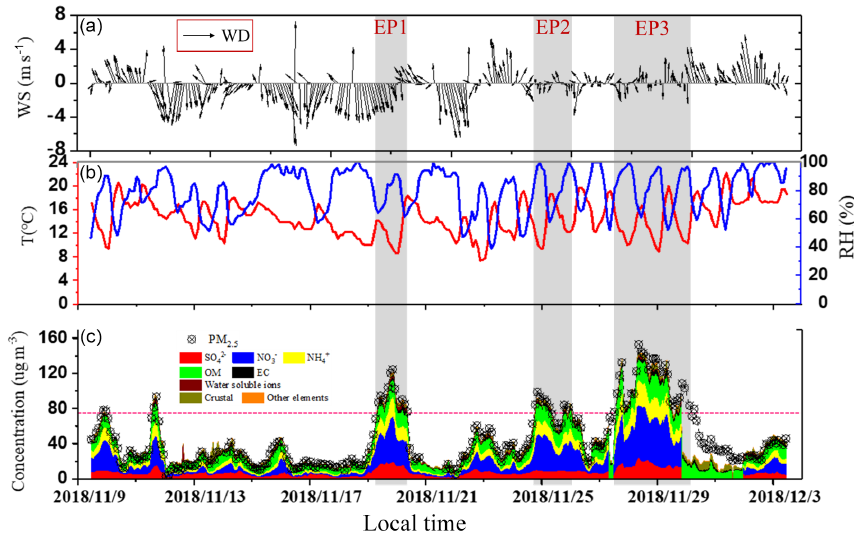
Figure 2. (a) Time series of wind speed (WS) and wind direction (WD), (b) time series of temperature ( T ) and relative humidity (RH), and (c) time series of PM 2 . 5 and its major components during the sampling period from 9 November to 3 December 2018. OM is estimated by assuming an OM / OC ratio of 1.8. Water soluble ions are the sum of Cl − , Na + , K + , and Mg 2 + . Crustal materials are calculated as the sum of the oxidized form of the crustal elements (i.e., crustal = 2 . 49[Si] + 1.63[Ca] + 2.42[Fe]). During 30 November to 1 December 2018, the major inorganic ions measured by MARGA are not available. The red line in (c) indicates the PM 2 . 5 level at 75µgm − 3 ; PM 2 . 5 concentrations higher than that are denoted as episodes; and the three episodes (EP1–3) are shaded in gray.